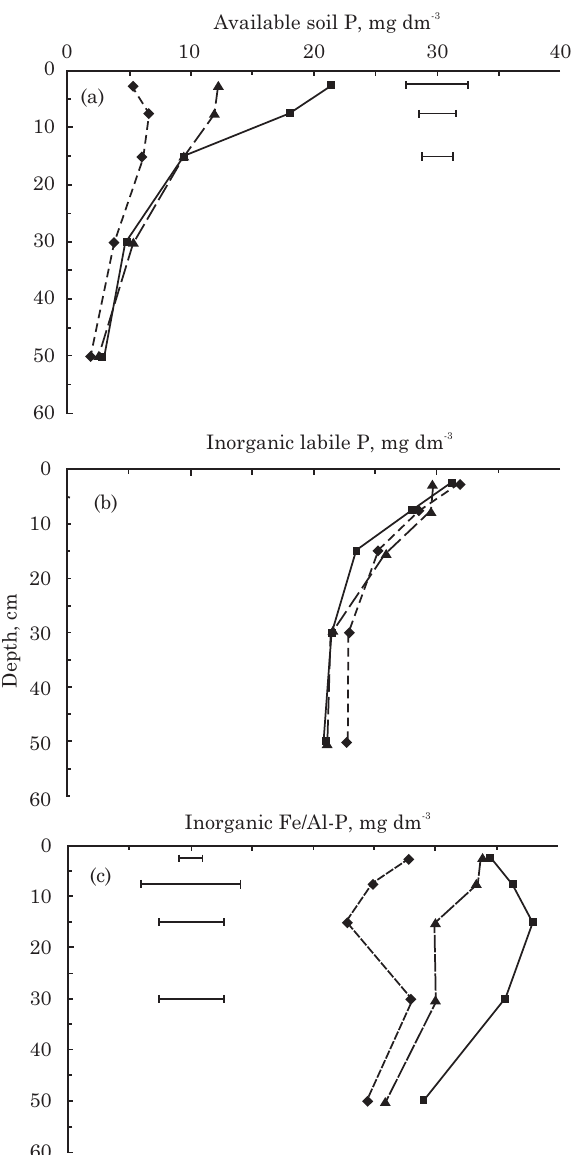
Figure 1. Available, inorganic labile, and Fe/Al-bound soil P as affected by surface-broadcast P fertilizers and depth. (a) P extracted with membrane resin; (b) Inorganic labile P; (c) Inorganic P bound to iron and aluminum. Dotted line – No P; dashed line - natural reactive Arad phosphate; solid line – triple superphosphate. Horizontal bars show LSD (p<0.05) and compare treatments within each soil